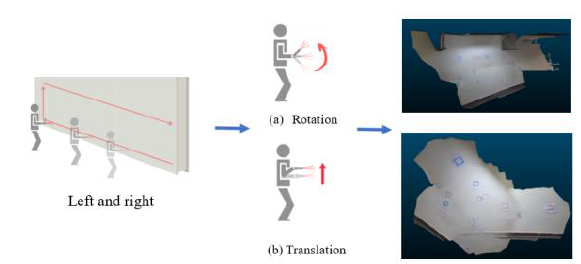
Figure 4. Result of the acquisition using a rotation (a) and a translation (b) of the camera.